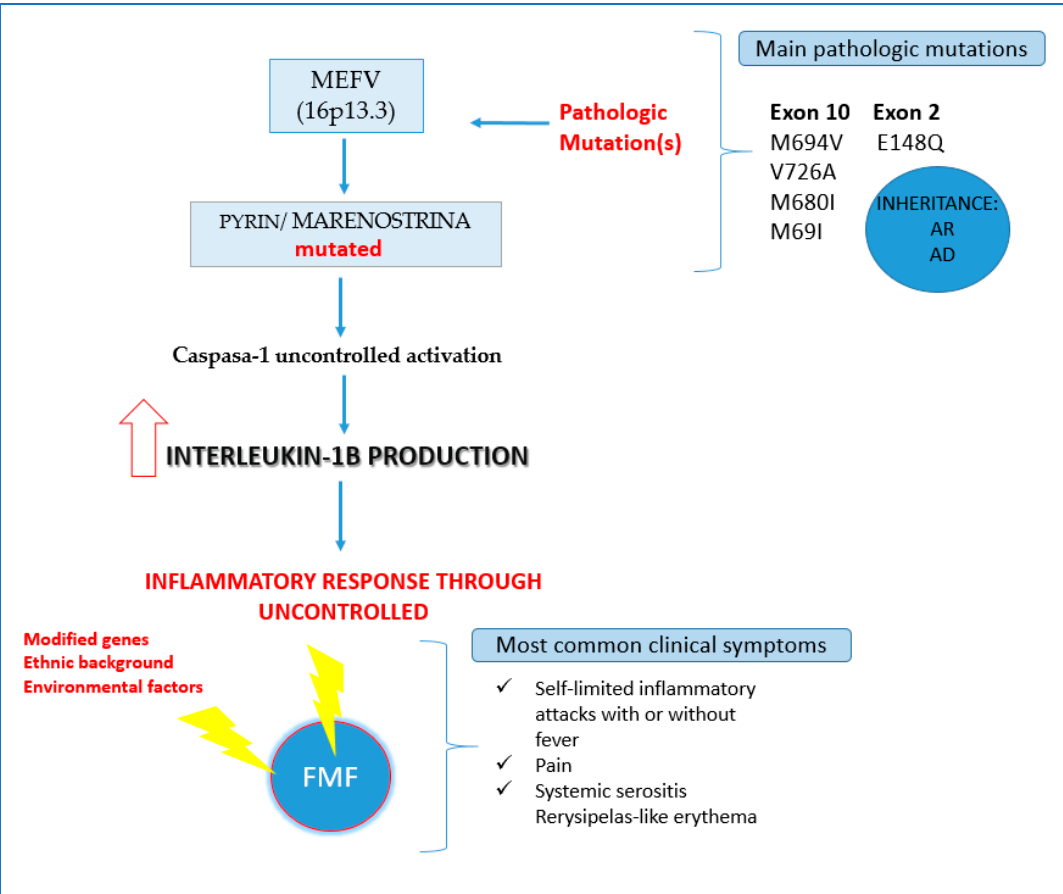
Figure 1. Inheritance of FMF and pathology associated with elevated IL-1. Elaborated by the au-